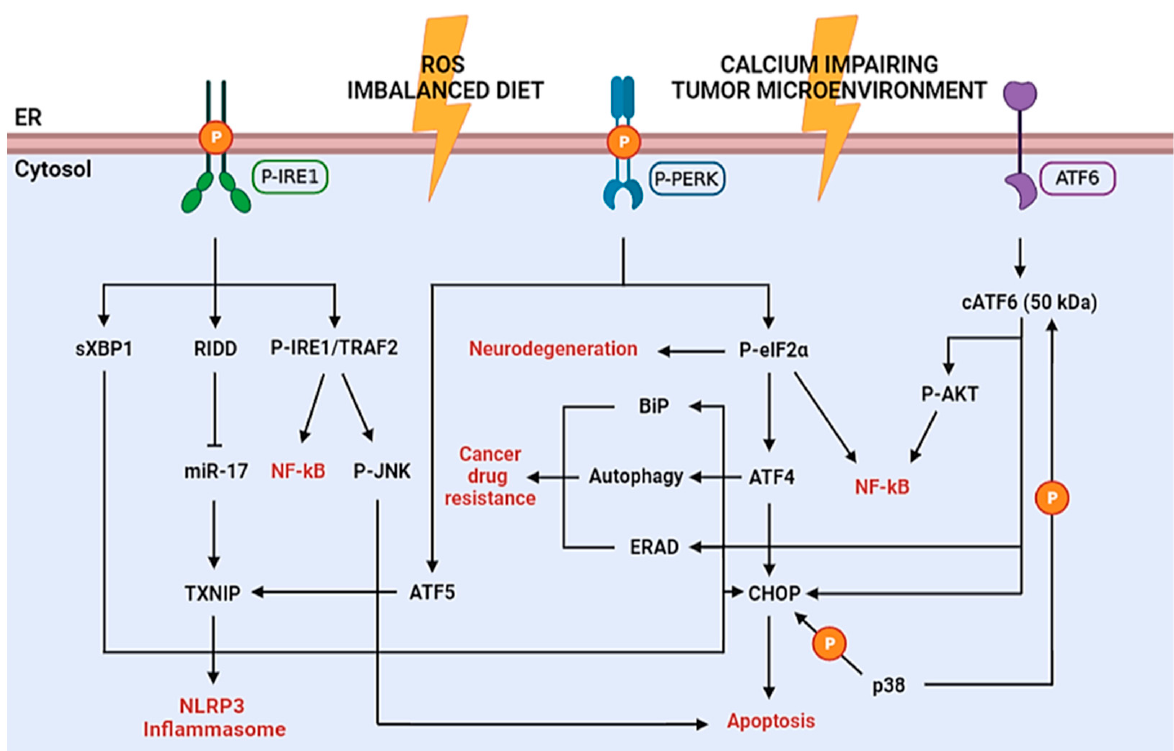
Figure 2. Schematic diagram of the UPR signaling in diseases. P-IRE1 and subsequent sXBP1 directly binds the promoters of UPR genes, which may lead to cell death (CHOP) or survival (ERAD, autophagy, BiP) depending on the intensity of the ER stress. IRE1 activates RIDD-dependent degradation of miR-17, which in normal conditions represses TXNIP, thus enabling increased TXNIP levels and NLRP3 inflammasome activation with consequent inflammatory cytokines